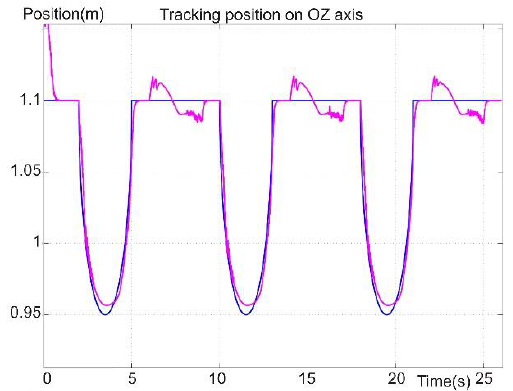
Figure 20. Foot reference and position tracking on the OZ axis.